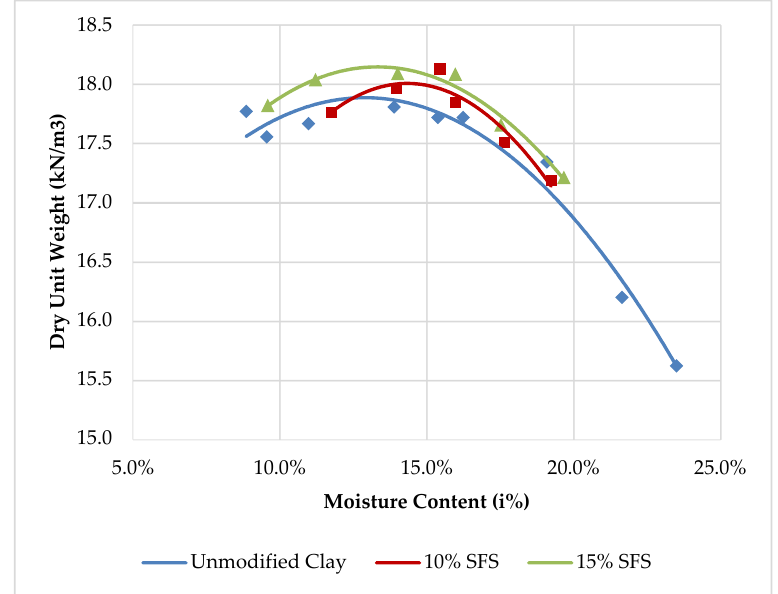
Figure 2. TGA result of the LMF slag, which indicates the weight loss and the derivative of the weight loss.